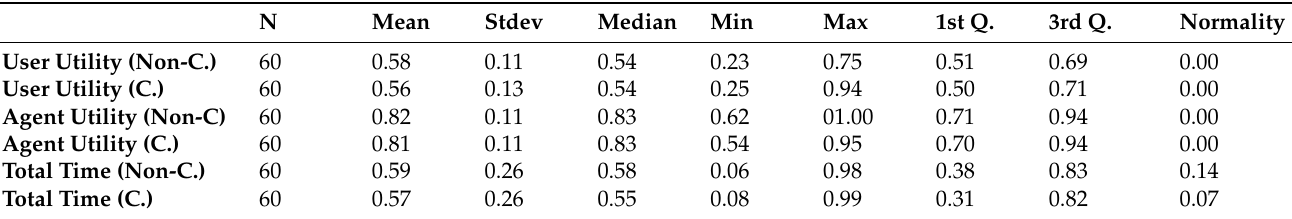
Table 2. Statistics for only Successful Negotiation Sessions.